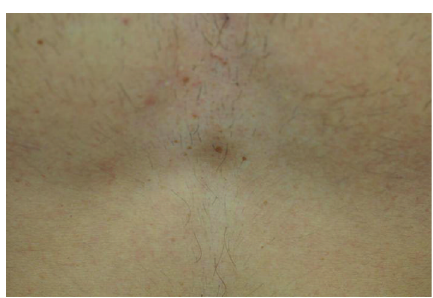
Figure 6: Nevus spilus, chest.